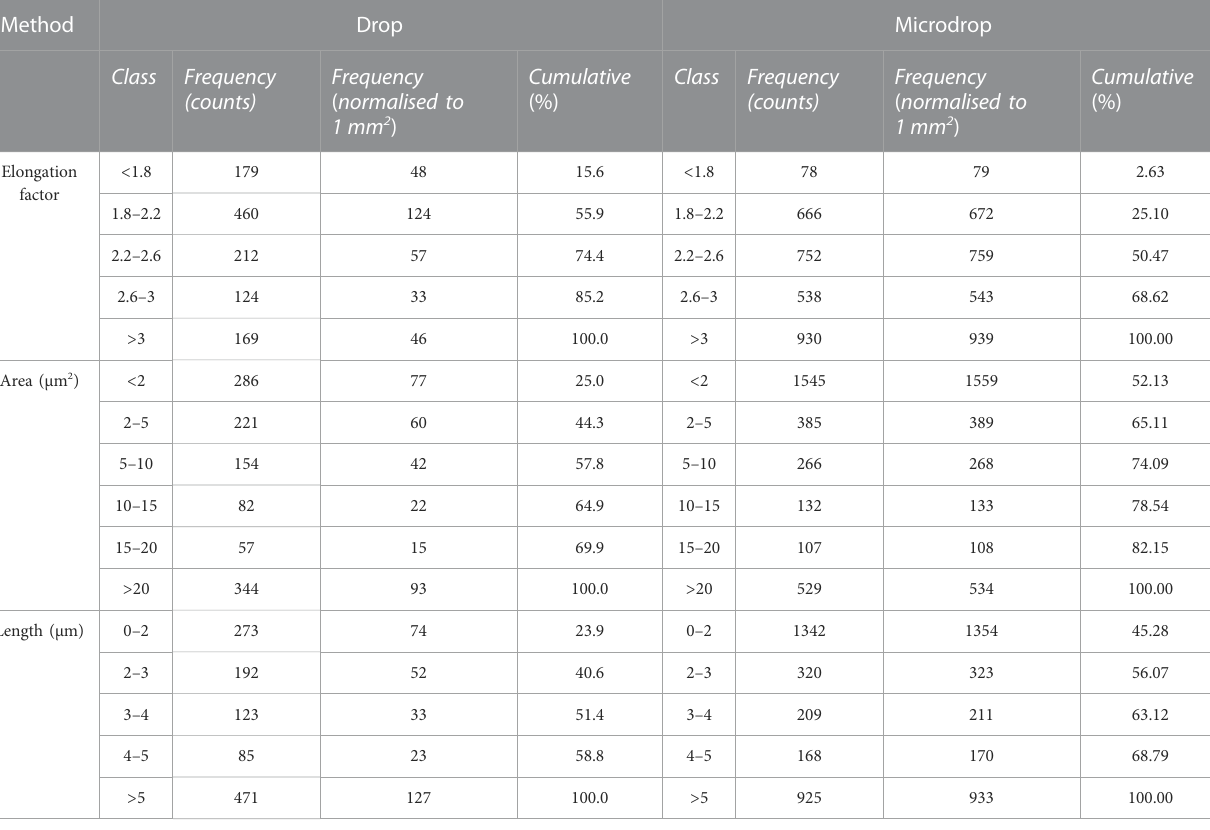
TABLE 2Resultsof the image processinganalysisfor samples obtained usingthe drop andthe micro-drop deposition methods, respectively.Fullresults are given in (Supplementary Table S1).